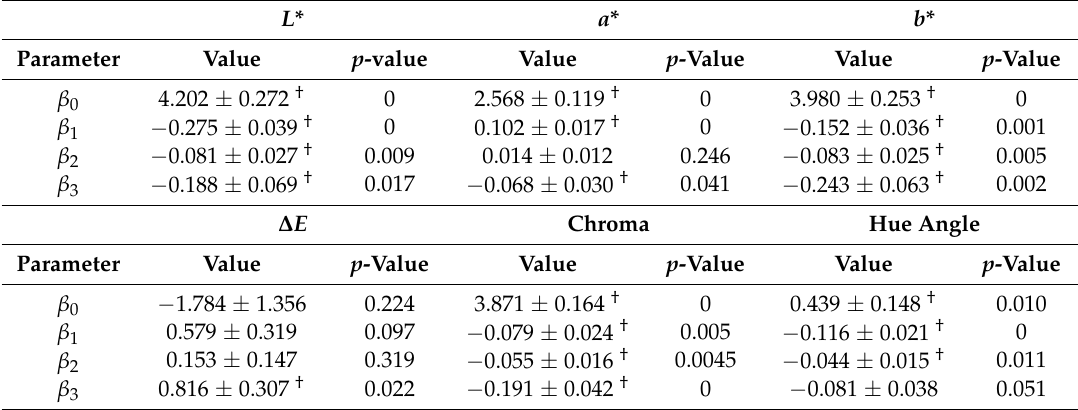
Table 7. Linear regression models coefficients for description of colour component change during the